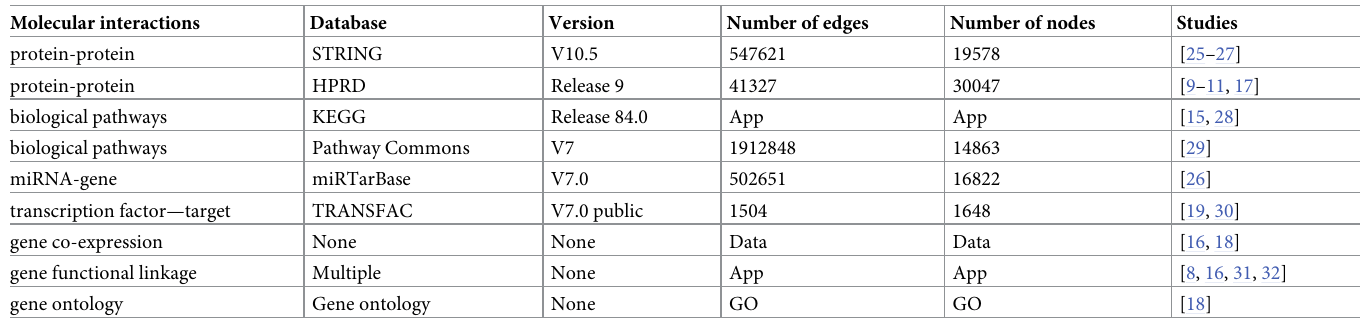
Table 1. Frequently used molecular/gene interaction networks in network-based feature selection studies. We listed below the basic information of the networks as well as exemplary studies that employed the networks. With STRING database we only considered the edges with confidence scores � 0.9. When a database has informa- tion of many species, only Homo sapiens was considered. In the 4th and 5th columns, Data means that the network size is dependent on the dimensions of data. App means that the network size is dependent on the application. GO means that the network size is dependent on gene ontology terms. Molecular interactions